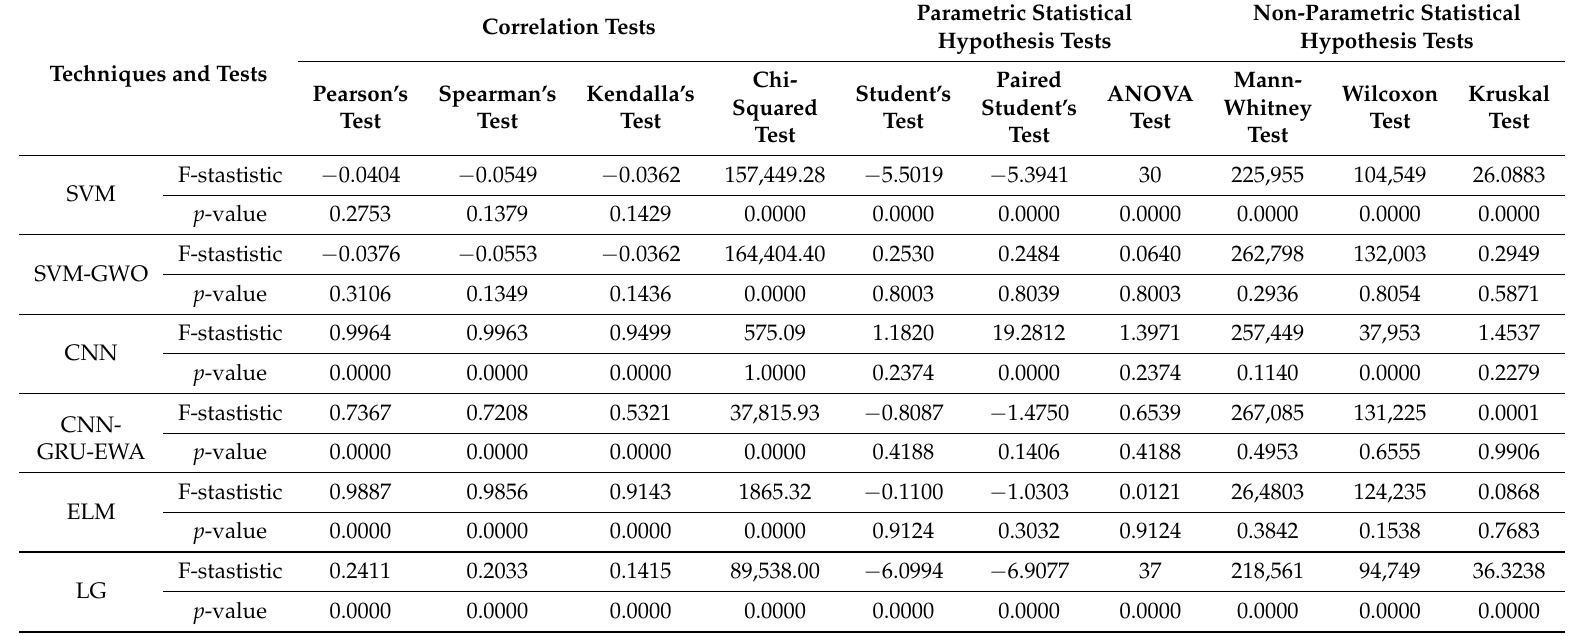
Table 4. Statistical analysis of proposed techniques and benchmark